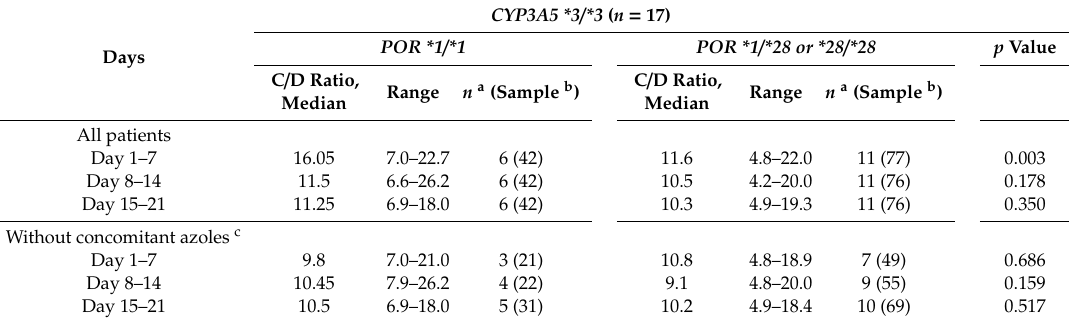
Table 4. Day + 1 to day + 21 median tacrolimus C / D ratio of CYP3A5*3 / *3 carriers according to POR genotype combinations ( n =